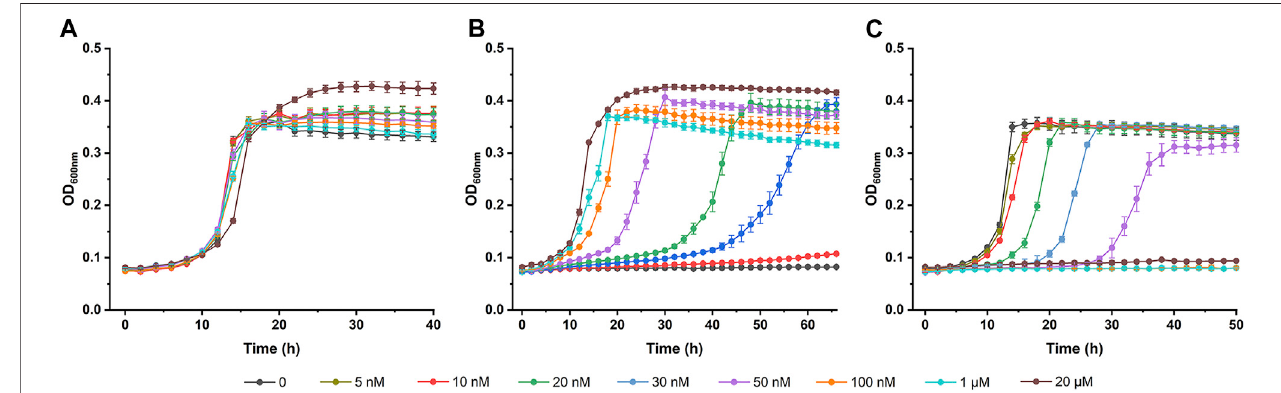
FIGURE6| Lanthanideconcentration-dependentgrowth ofderivative strainsof P.putida KT2440in(2 S ,3 S )-2,3-BDO. P.putida KT2440wild-type (A) , Δ pedE (B) and Δ pedH (C) mutant strains were cultured in MSM supplemented with 2 g L − 1 (2 S ,3 S )-2,3-BDO with various concentrations of LaCl 3 at 30 ° C by using a Bioscreen microbiology reader. Error bars indicate deviation from the means ( n (cid:2) 3).